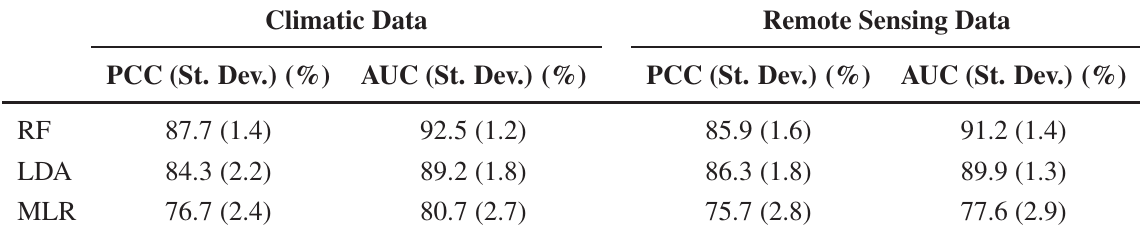
Accuracy measures of C. imicola distribution models for different modelling techniques and input